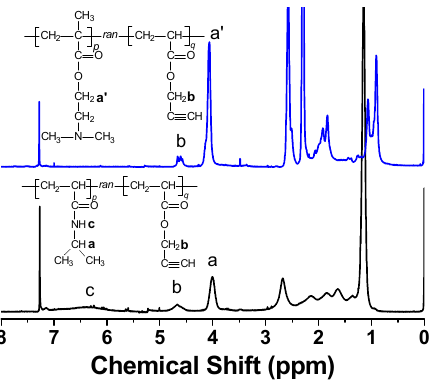
Figure 3. The 1 H-NMR spectra of P(DMAEMA- co -ProA) ( upper ) and P(NIPAM- co -ProA) ( lower ) in CDCl 3 . Table 2. Characterization results of P(NIPAM- co -ProA) and P(DMAEMA- co